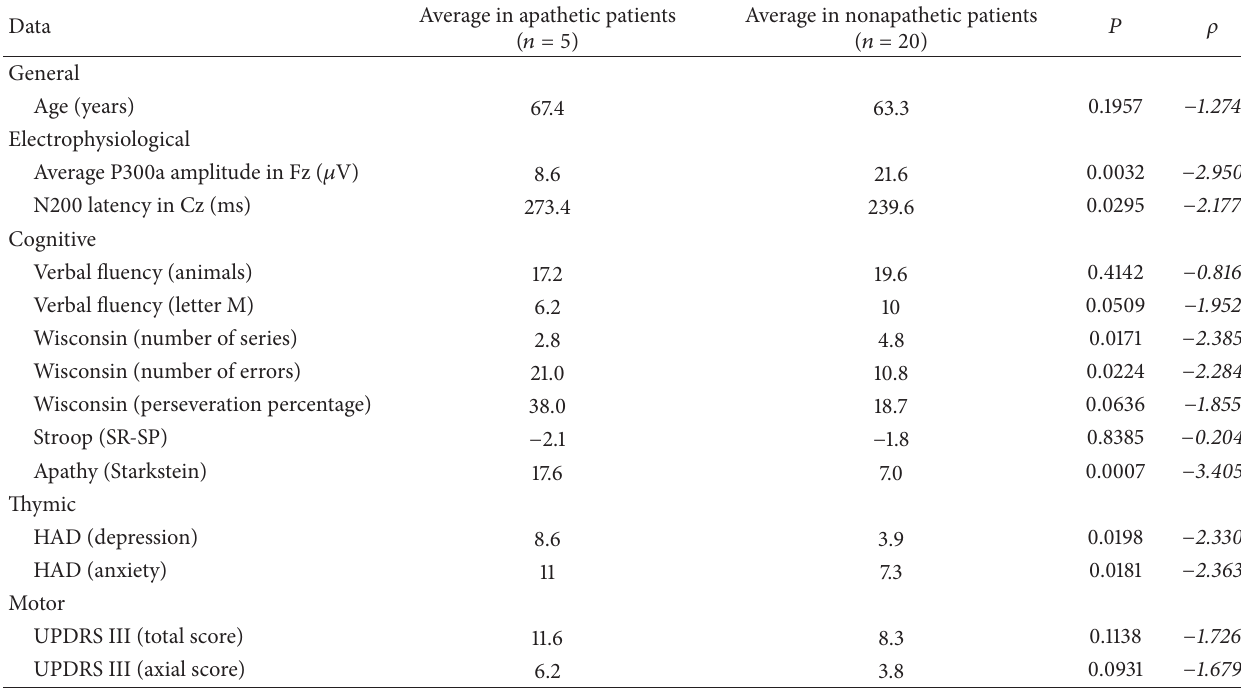
Table 3: Characteristics distinguishing apathetic from nonapathetic patients during ON